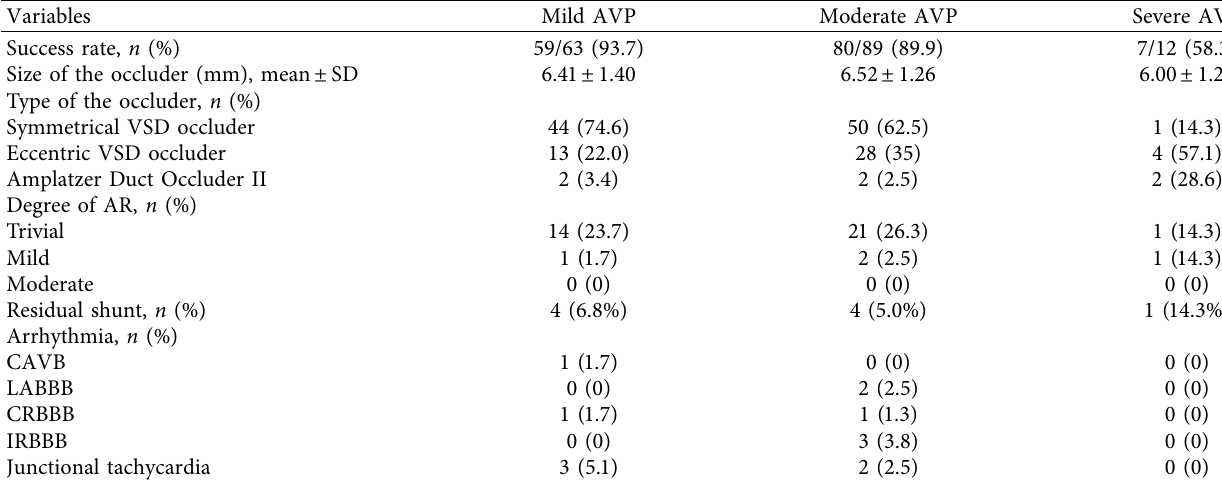
Table 3: Procedural results of different degrees of aortic valve